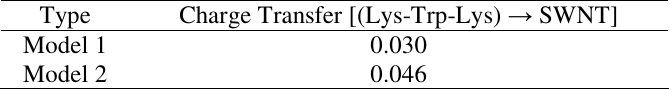
Table 4. Charges calculated for the interaction of tripeptide with